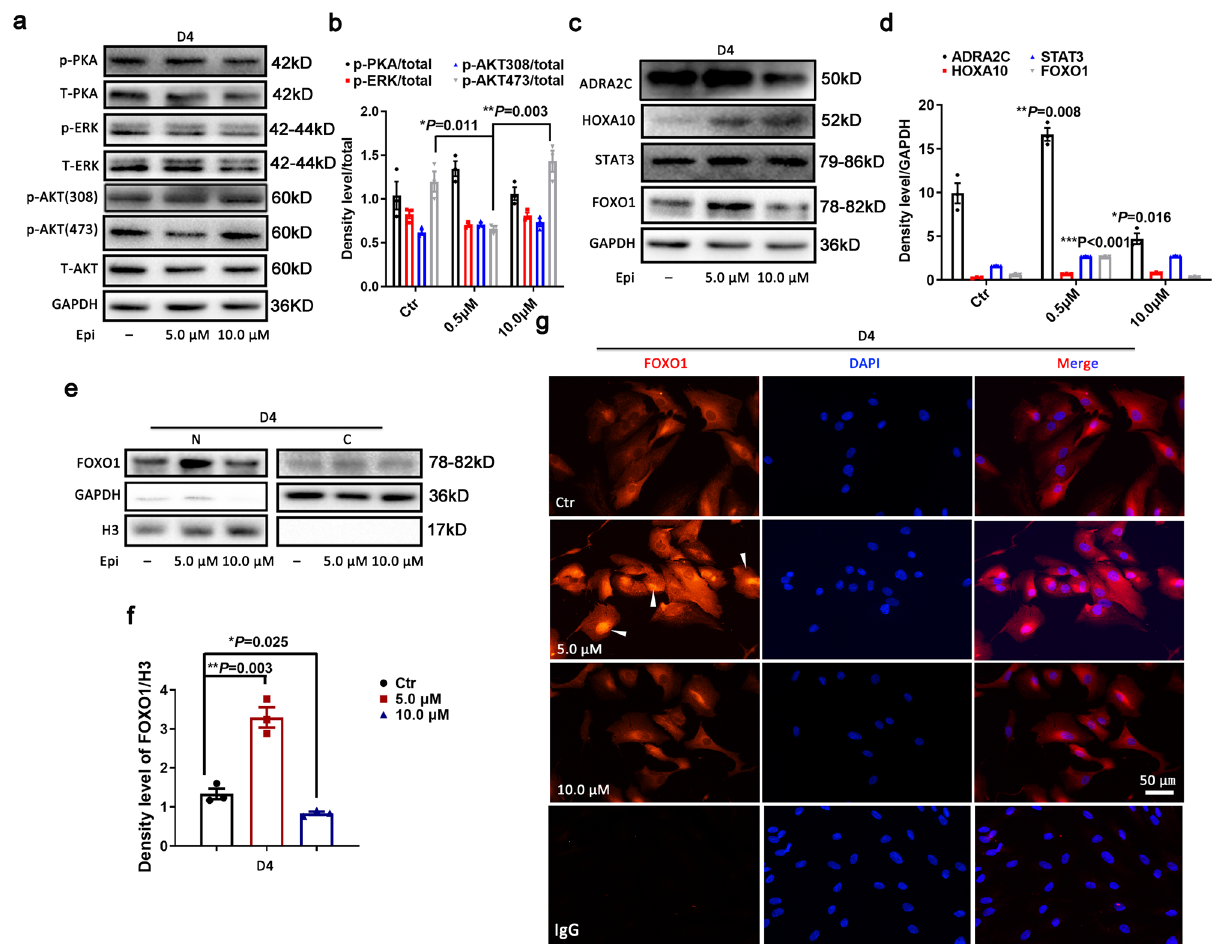
Fig. 4 The adrenergic signaling pathway downregulates AKT activity, associated with increased FOXO1 expression and nuclear localization. a Western blot analysis of total protein and active forms of PKA, ERK, and AKT signaling pathways in D4 decidualized cell with different treatments. b Relative fold change in density levels for a . c Western blot analysis of ADRA2C and decidual development-related transcription factors HOXA1O, STAT3, and FOXO1. d Relative fold change in density levels for c . e Western blot analysis of FOXO1 in the nucleus and cytoplasm fraction. N nucleus, C cytoplasm. f Relative fold change in density levels for e . g Expression and localization of FOXO1 by cellular immuno fl uorescence assay. The arrow points out FOXO1 in the nucleus. Scale bars, 50 μ M. IgG for